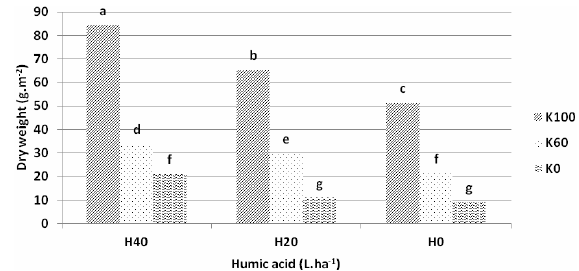
Fig. 2. Effect of humic acid and potassium sulphate on dry weight in the first cutting